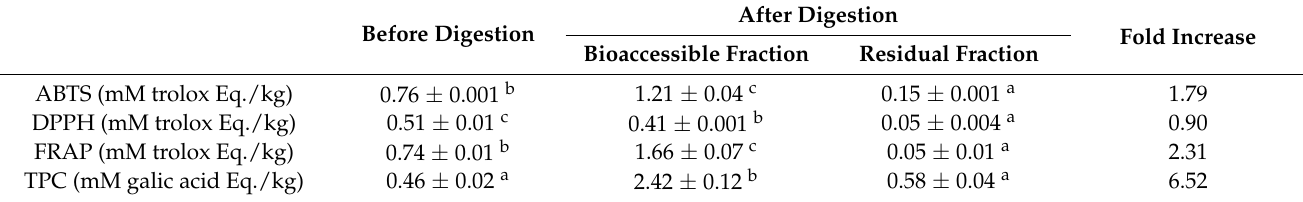
Table 3. Antioxidant activity by ABTS (2,2 (cid:48) -Azino-bis(3-ethylbenzothiazoline-6-sulfonic acid)), DPPH (2,2 diphenyl-1-picrylhydrazyl) and FRAP (ferric reducing antioxidant power), and total phenolic content (TPC) of the whey-beverage ( Colada ) before and after the in vitro digestion. After Digestion Before Digestion Fold Increase Bioaccessible Fraction Residual Fraction ABTS (mM trolox